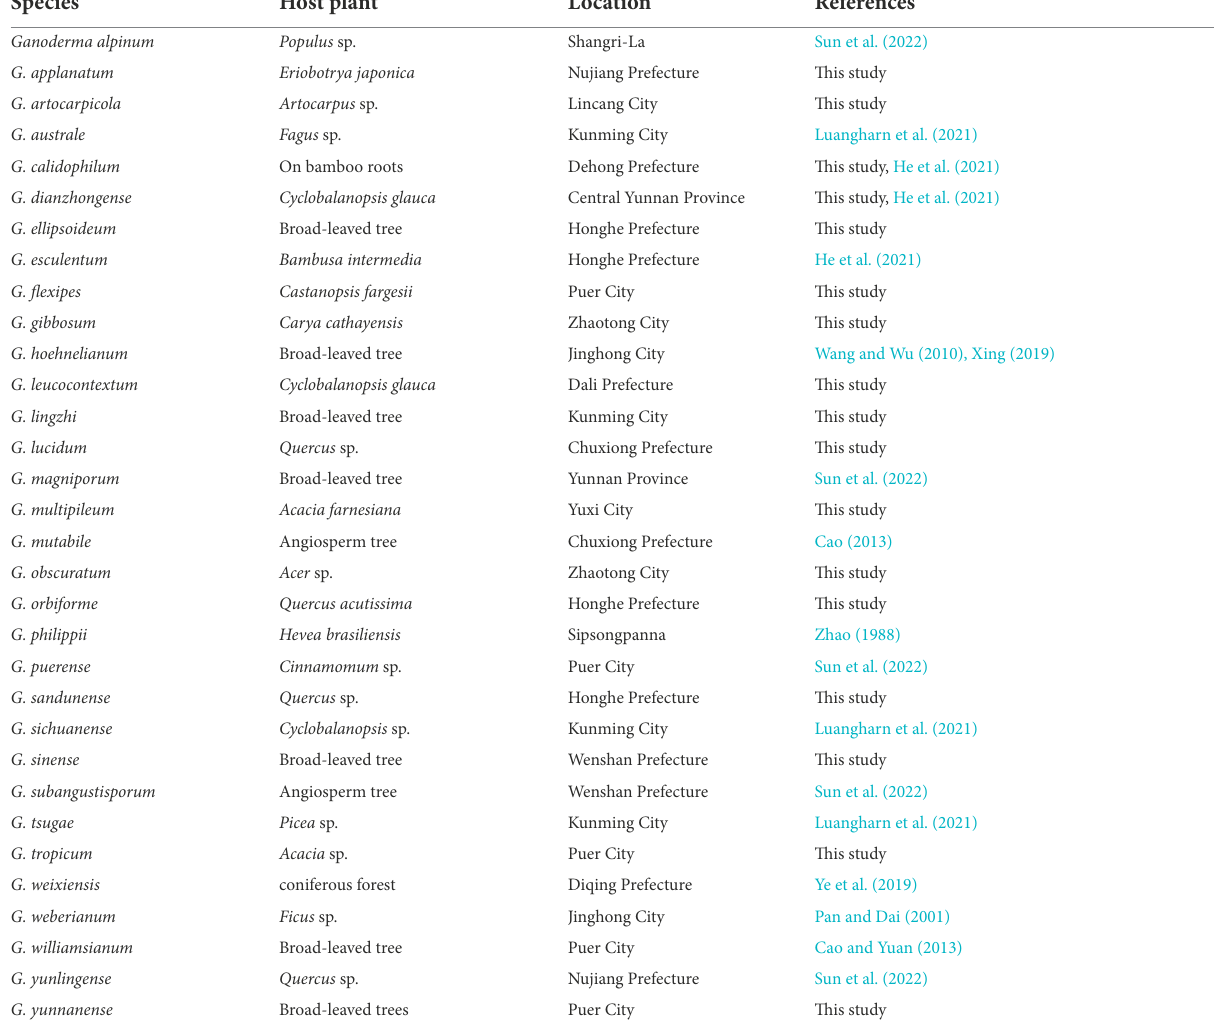
TABLE 3 Species, hosts, and geographical locations and corresponding references of Ganoderma in Yunnan Province,